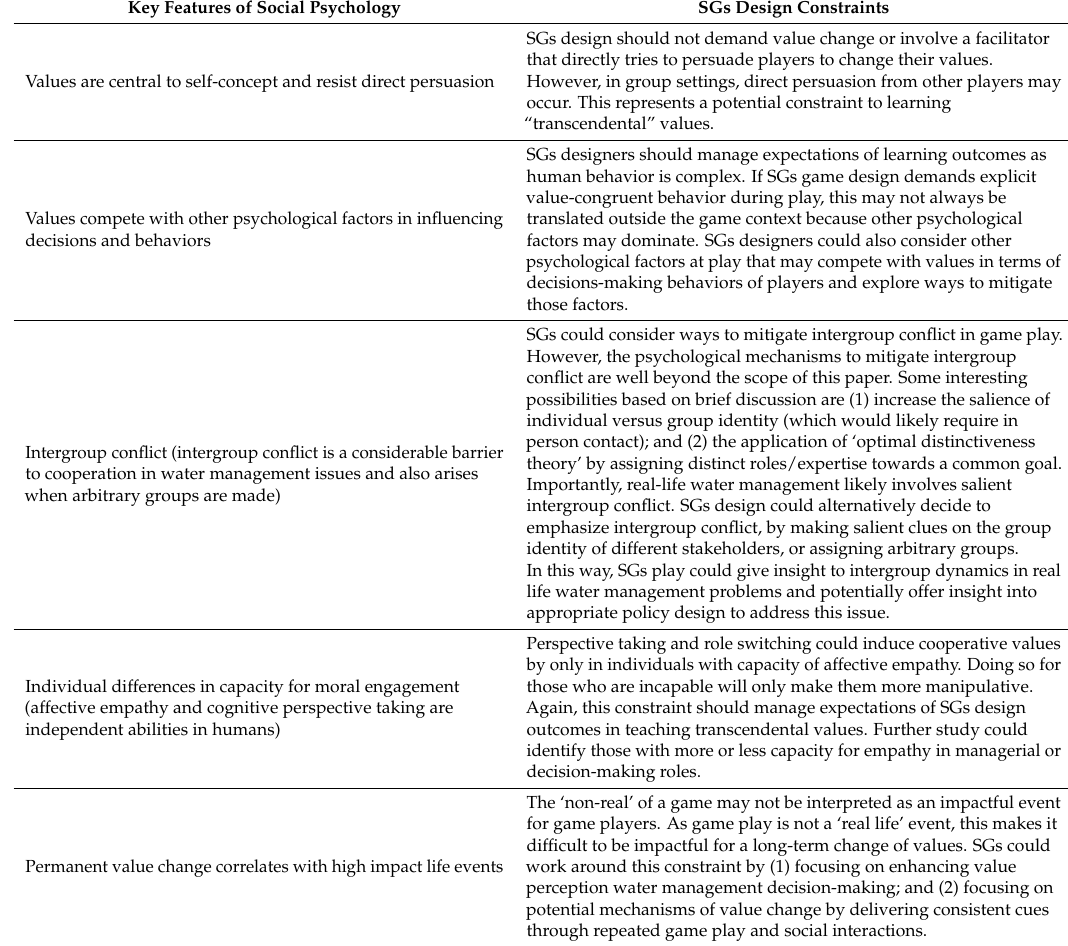
Table 3. Key constraints to consider in SGs design for developing transcendental